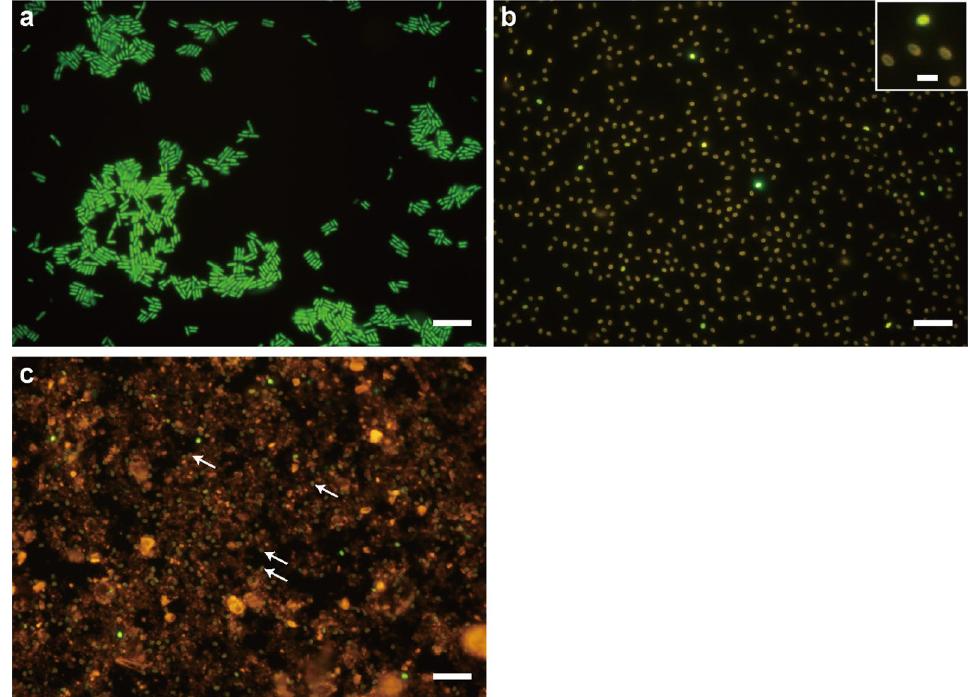
Fig. 3 SYBR Green I staining of vegetative cells ( a ) and endospores ( b ) of Bacillus subtilis NBRC13719. This figure illustrates the difficulty in identifying spores even of pure cultures of organisms that are mixed into sterilized sediments. In ( c ), endospores were mixed in sterilized sediment prior to staining by SYBR Green I. Several representative yellowish endospores, which are difficult to distinguish from sediment particles, are indicated by white arrows as examples. Bars represent 10 μm. Adopted from Heuer et al.